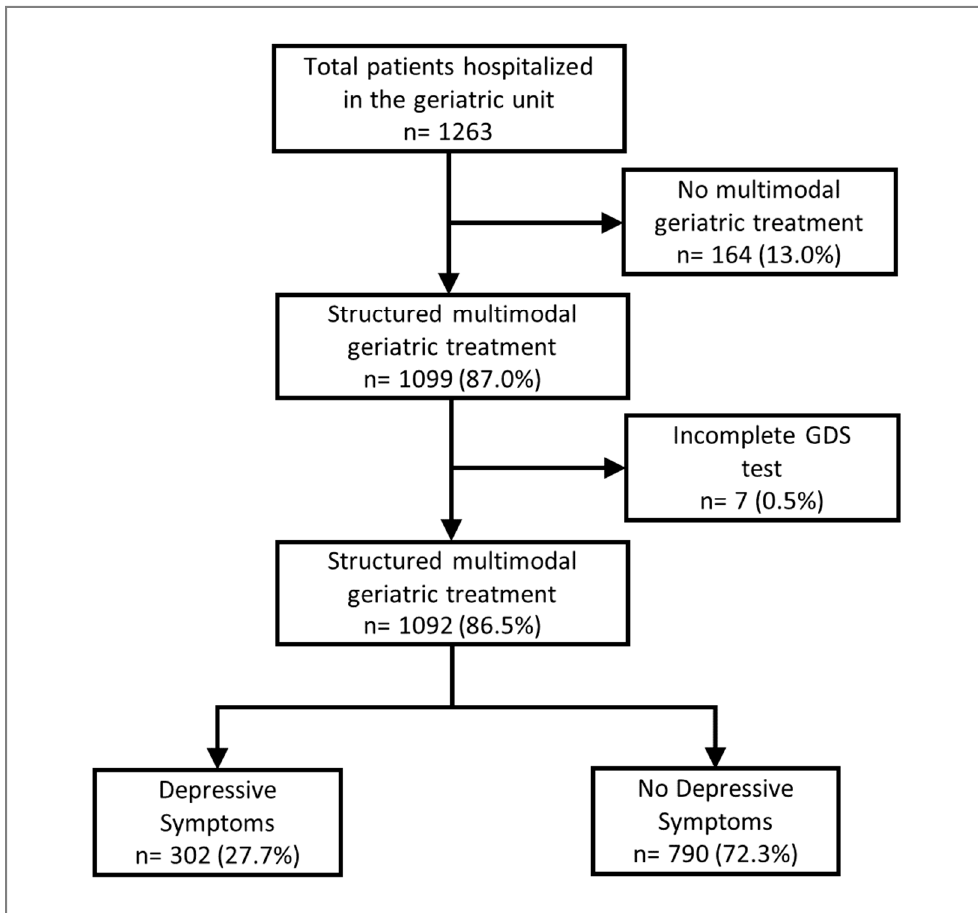
Figure 1. Patient selection. ‘GDS’ = Geriatric Depression Scale.